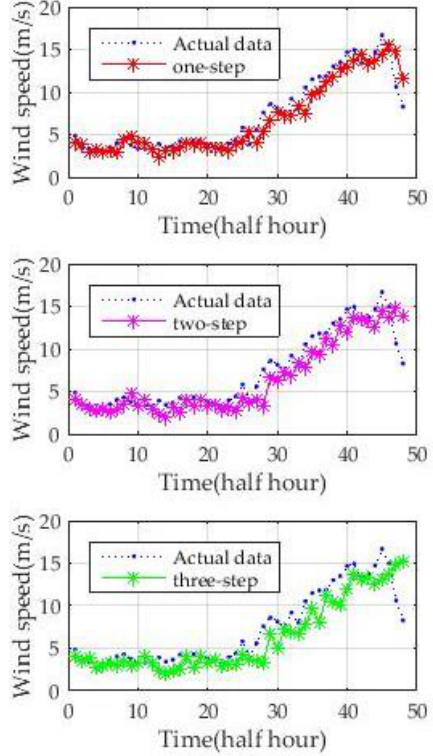
Figure 8. Forecasting results on 20 May 2004.